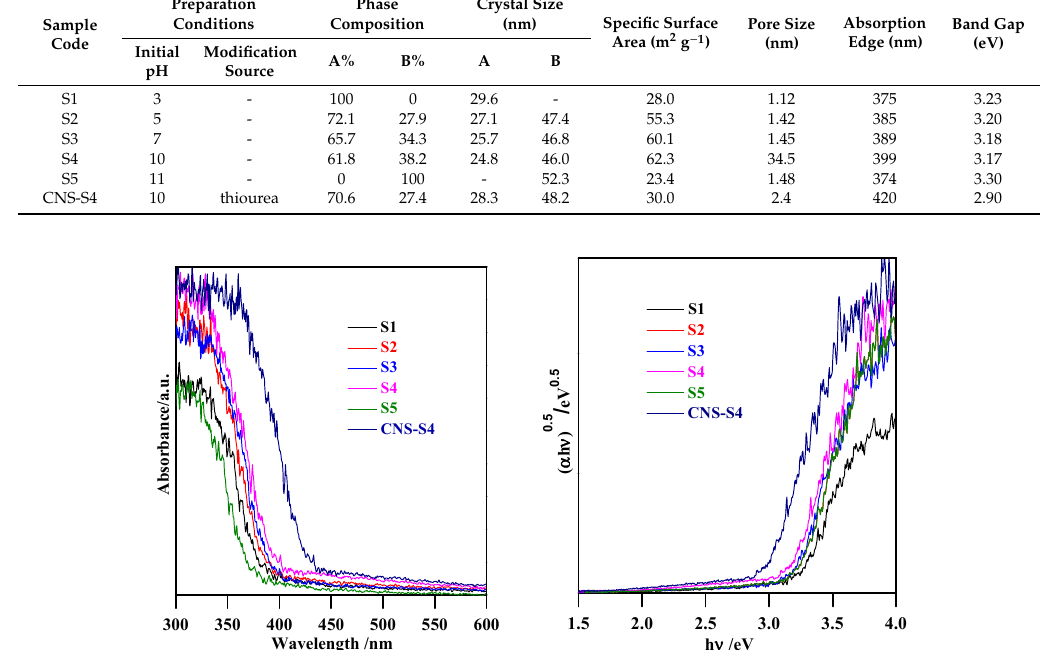
Figure 2. FE-SEM images of: ( a ) S1; ( b ) S5; ( c ) S4; and ( d ) CNS-S4. Table 1. Preparation conditions, phase composition, crystal size, specific surface area, particle size, absorption edge and band gap of S1, S2, S3, S4, S5 and CN / S-S4 catalysts. Sample Code